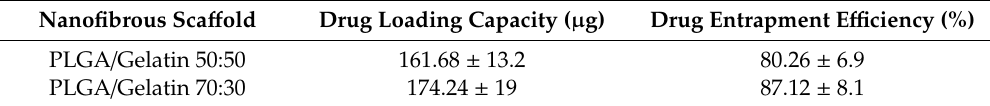
Table 1. Drug loading capacity and drug entrapment e ffi ciency of nanofibrous sca ff